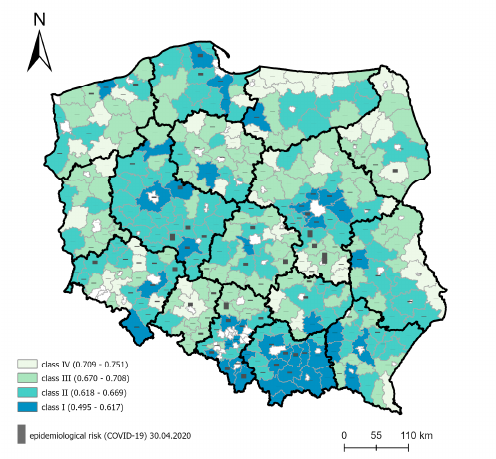
( B ) Relationship between area classification and epidemiological risk (COVID-19)—pandemic wave